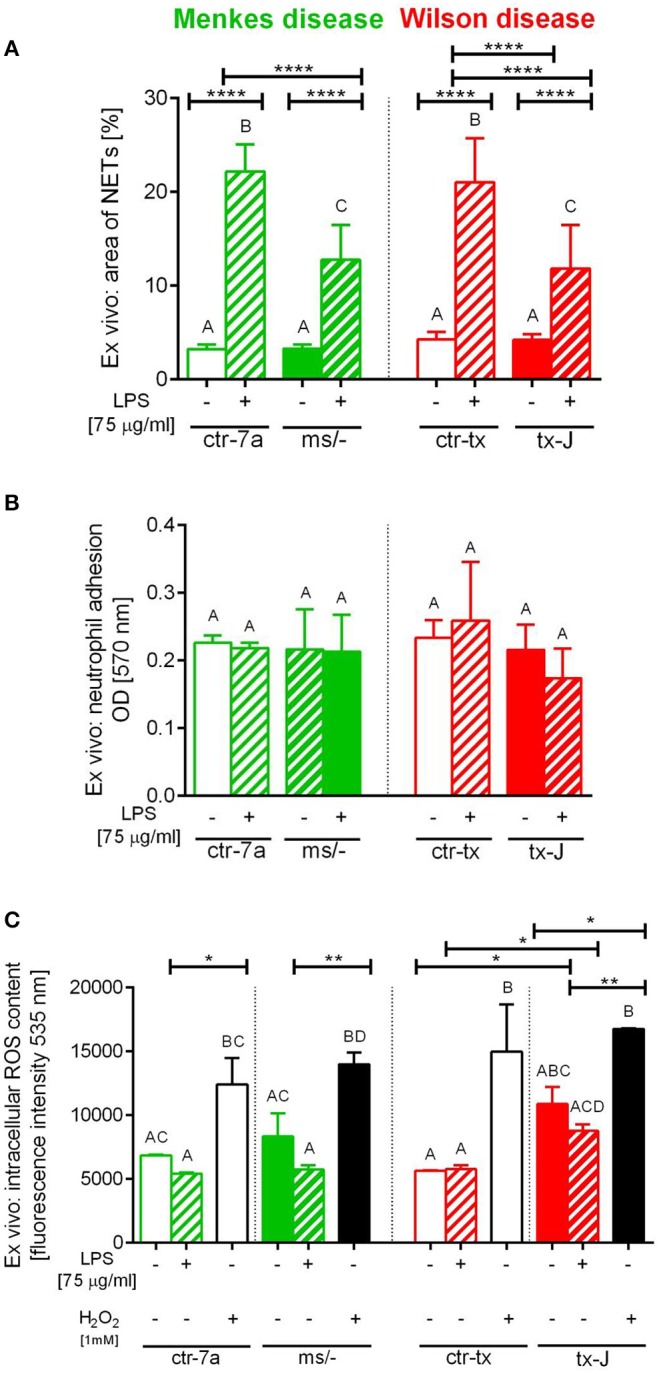
Ex vivo studies on isolated bone marrow neutrophils of Wilson (tx-J) and Menkes (ms/−) disease mice and their respective controls (ctr-tx and ctr-7a) evaluating their capacity to form NETs (A), adhere (B), and release reactive oxygen species (ROS; C). NET formation and capacity to adhere were evaluated 6 h after stimulation with LPS, and the content of ROS was measured after the first hour (DCF-DA test). In (C), white/black bars represent responses of cells treated with H2O2 (positive control)—data for neutrophils from control mice (white bars) and mutants (black bars). Asterisks indicate significant differences using unpaired two-tailed Student's t test (*P ≤ 0.05, **P ≤ 0.01, ****P ≤ 0.0001) and one-way ANOVA (post hoc Bonferroni) test (different letters indicate statistically significant differences between groups).